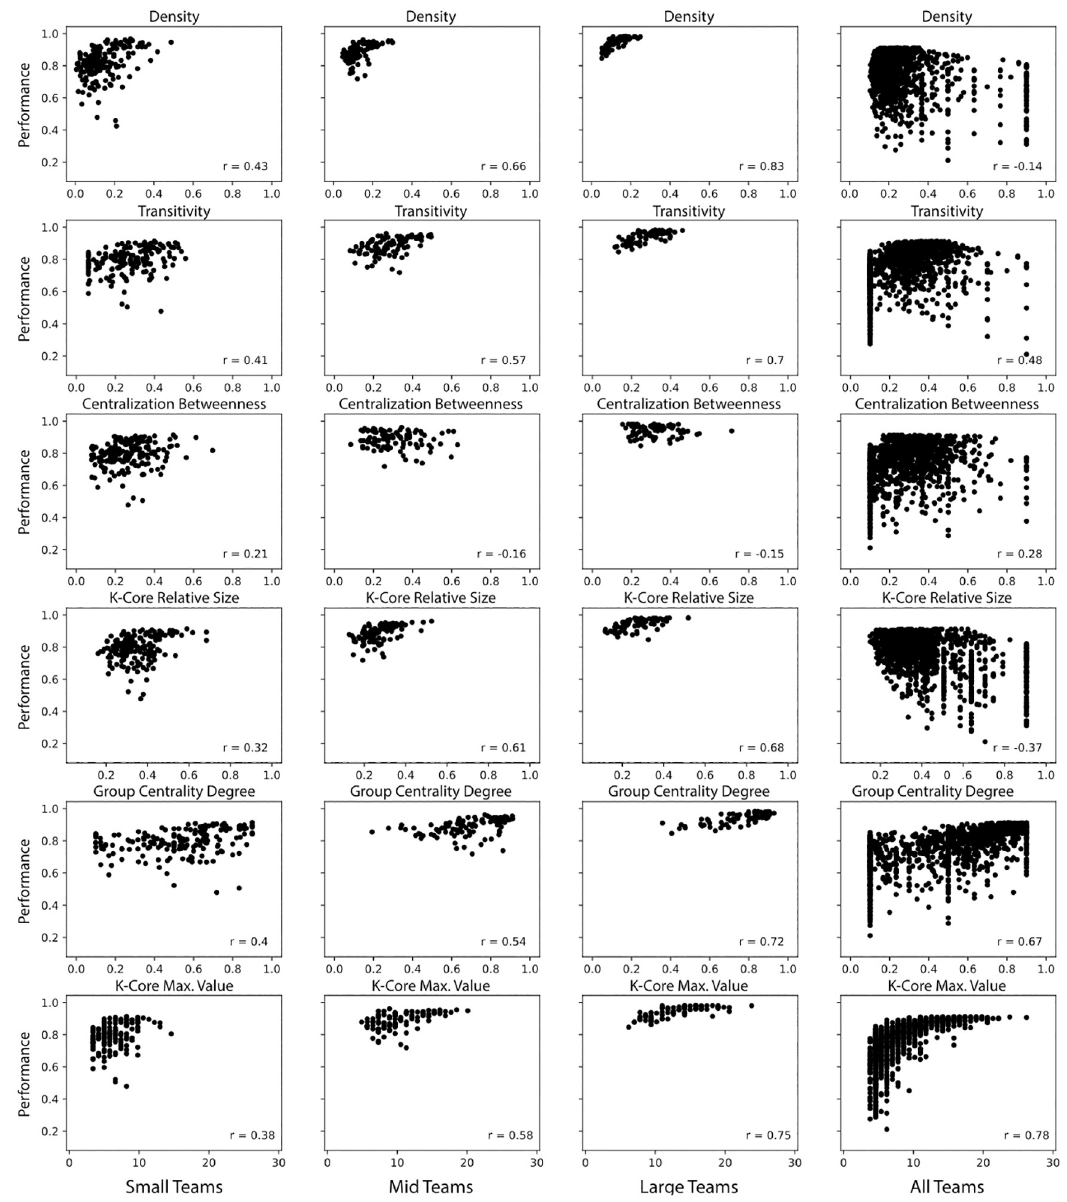
Fig 6. Communication networks. Correlation of each measure with team performance for the groups of small-, mid-, large-size teams as well as all teams.